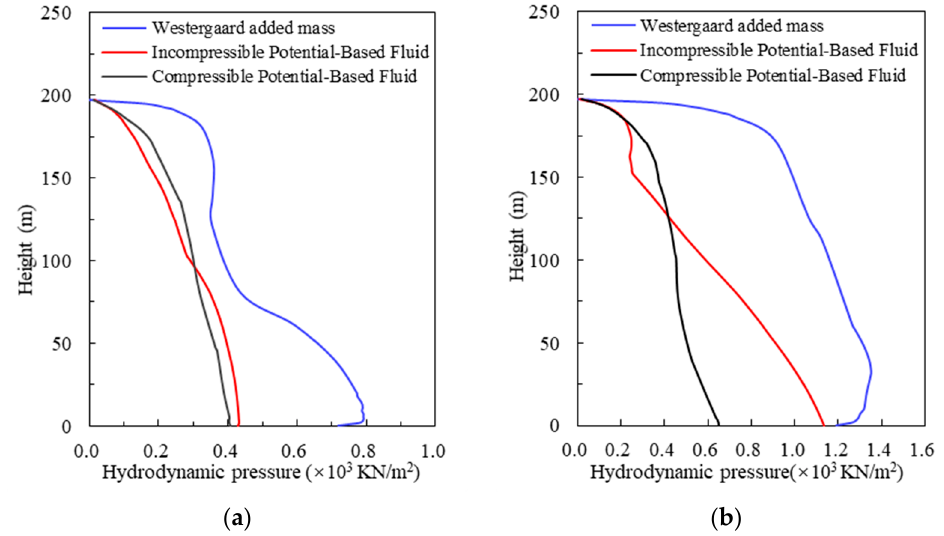
Figure 14. Hydrodynamic pressure distributions along the dam–reservoir interface. ( a ) The VABF model, ( b ) the MLF model. model, ( b ) the MLF model.